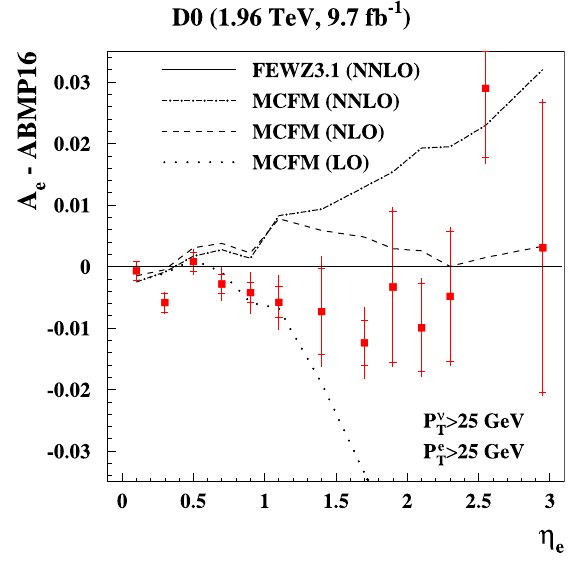
Fig. 12 Same as Fig. 11 using predictions by the MCFM code